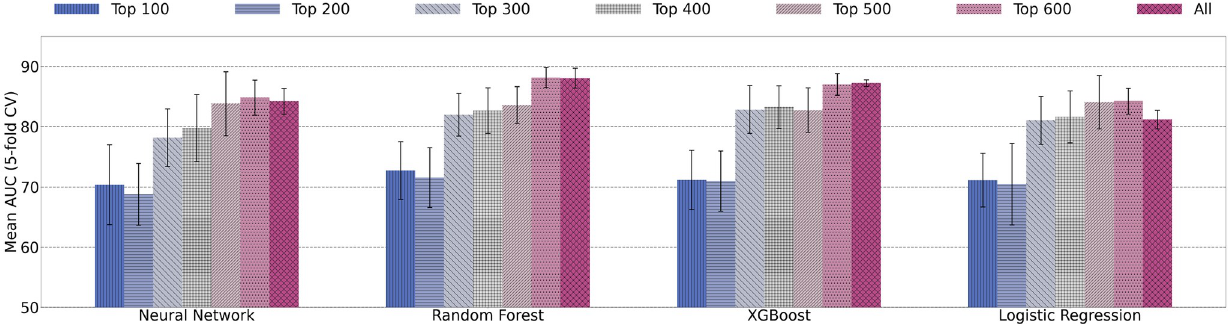
Fig 12. Mean AUC values and standard deviation of single models trained using increasing number of features.